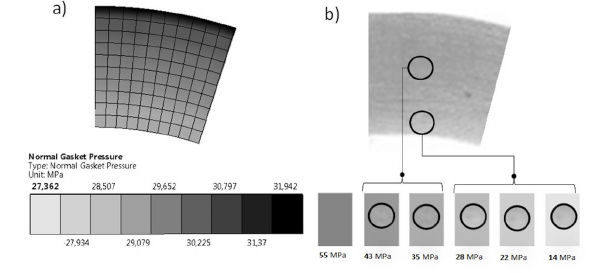
Figure 22: The comparison of numerical and test results of the con- tact stress distribution on the gasket FG_2 in state I-0 correspond- ing to tightness